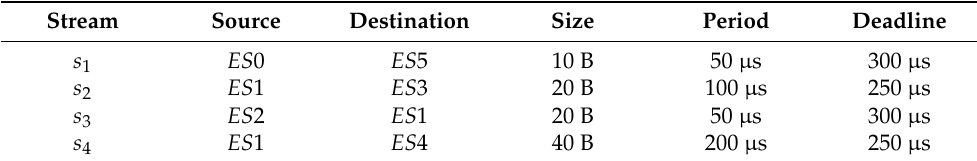
Table 1. The S used for the motivational example.